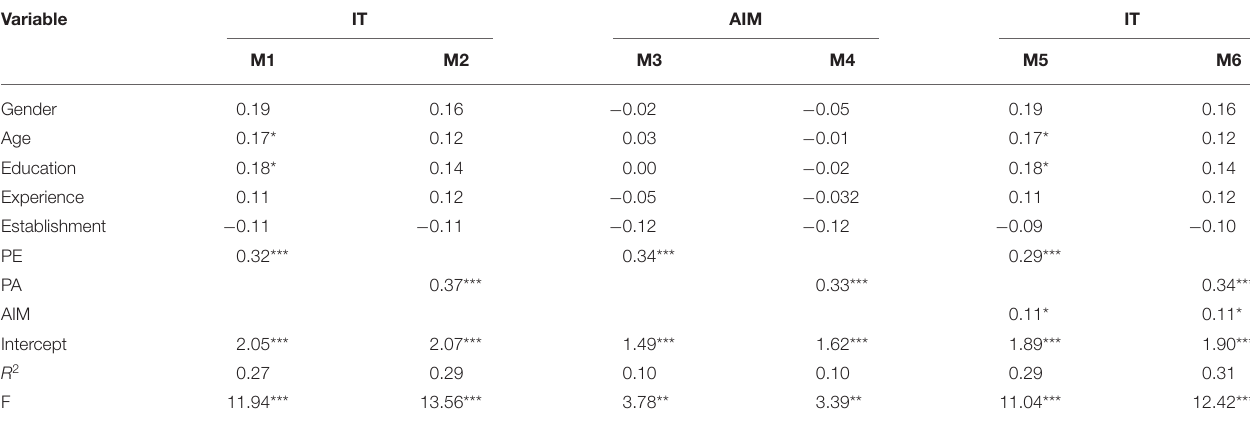
TABLE 3 | The mediation effect test of acquired impression management strategies. Variable IT